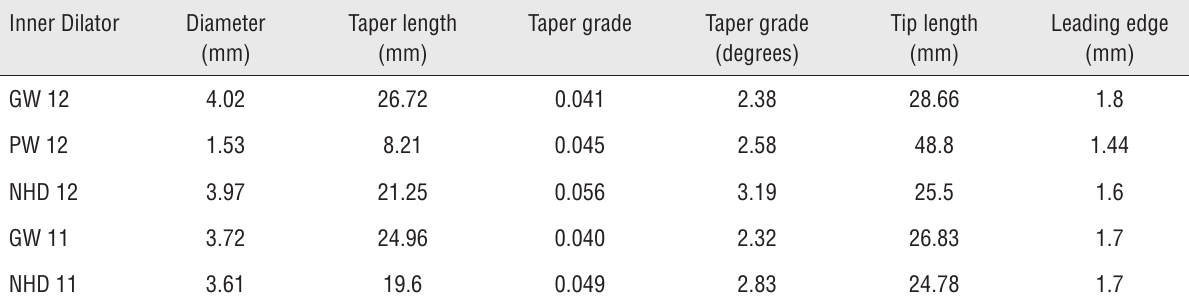
Table 2 - Tip contour Measurements.